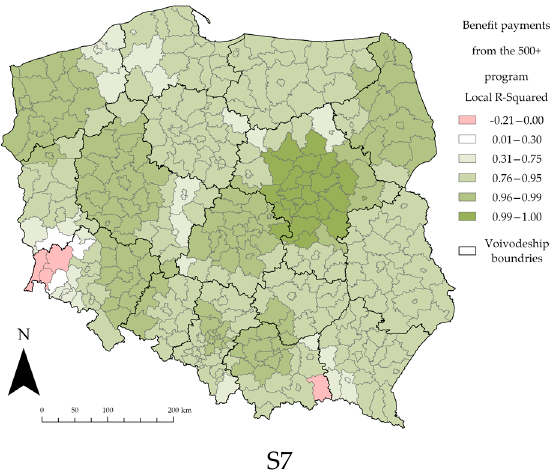
Figure 6. Local R 2 estimates for the “Social” section. Source: own elaboration using ArcGIS Pro 2.9 by Esri.